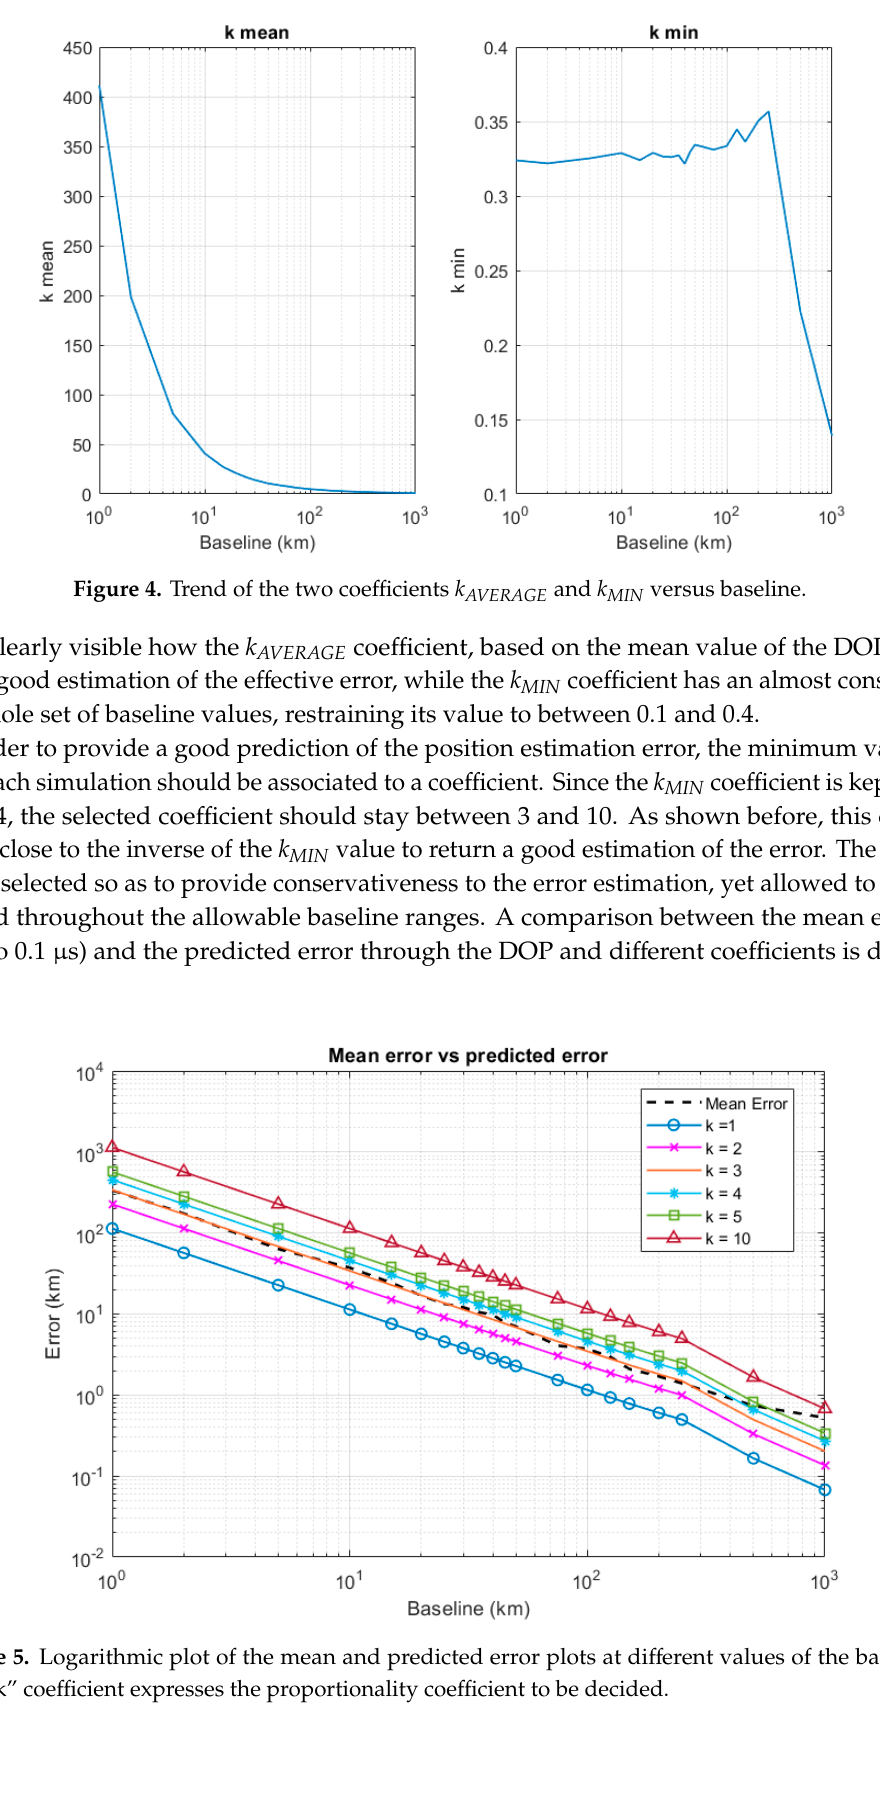
Figure 5. Logarithmic plot of the mean and predicted error plots at different values of the baseline. The “k” coefficient expresses the proportionality coefficient to be decided.